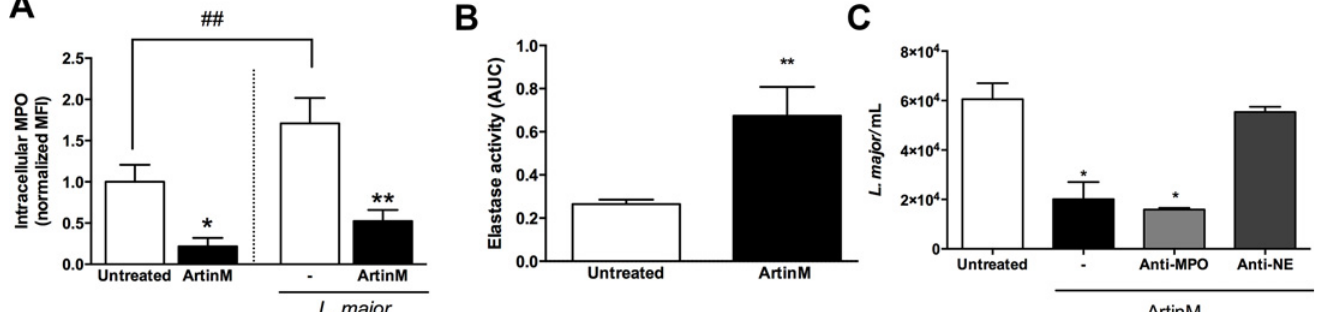
Fig 3. ArtinM stimulates the degranulation of L . major -infected or uninfected neutrophils. A – Intracellular levels of myeloperoxidase. Human neutrophils were incubated for 20 h with ArtinM or medium only (untreated), and infected or not infected with L . major promastigotes (MOI 3:1); cells were permeabilized and reacted with anti-MPO PE . Cells were analyzed by flow cytometry and data were expressed as normalized mean ± SD of the median fluorescence intensity. * p < 0.02, ** p < 0,01. Student's t test. B – Elastase releasing. Human neutrophils were stimulated with ArtinM or medium only (untreated); Cell supernatants were monitored for 30 min for enzymatic activity, using the substrate N-succinyl-Ala-Ala-Val-p-nitroanilide. The NE activity was expressed as the area under curve (AUC) ± SD. ** p < 0.05 in comparison to untreated cells. Student's t test. C – Elastase leishmanicidal activity. Supernatants from neutrophils treated for 1 h or not treated with ArtinM were incubated for 30 min (or not incubated) with anti-MPO or anti-NE antibodies (both 1:500). Next, supernatants were added to L . major culture (1x10 5 ), in Schneider ’ s medium. After 24 h, live parasites were quantified by reaction with Alamar Blue. Data are expressed as the number of viable parasites ± SD. * p < 0.05 in comparison to the supernatant from untreated cells. One way ANOVA, followed by Bonferroni's post-test. Each assay was carried out in duplicate. The shown data are representative from three different